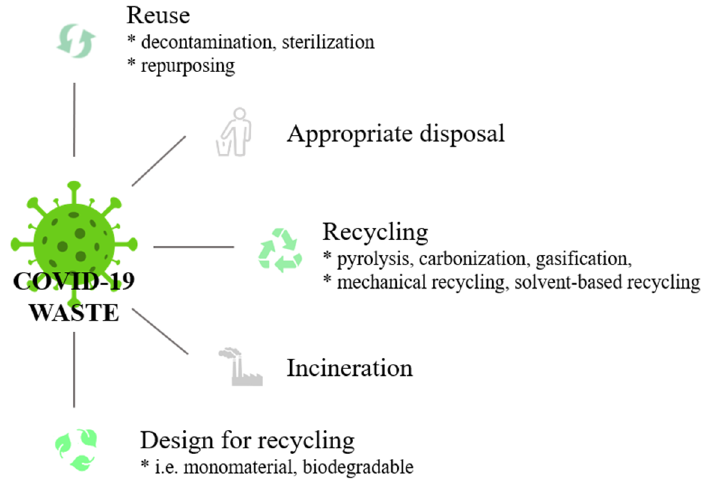
Figure 2. Zero-waste approaches to address COVID-19